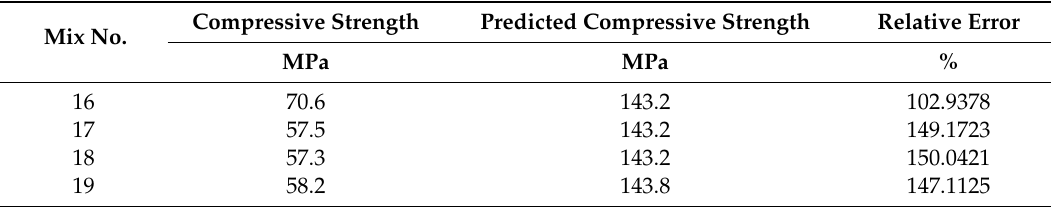
Table 2. The prediction results of the linear regression